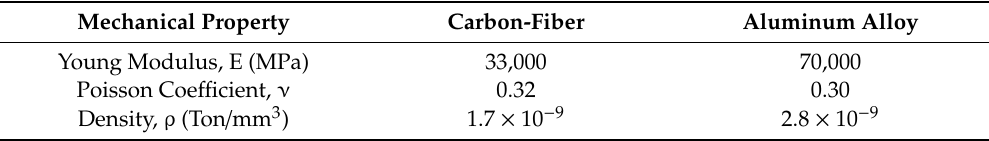
Table 1. Materials properties of the winglet.